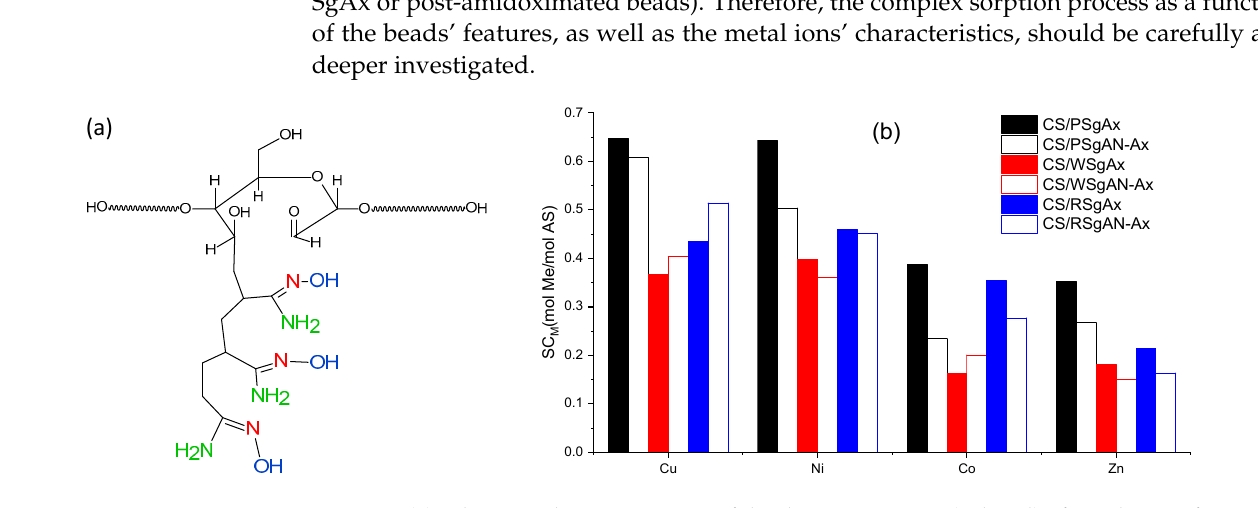
Figure 9. ( a ) Schematical representation of the three active sites (colored) of amidoxime functional group and ( b ) sorption capacity of hydrogel beads CS/SgAN-Ax or CS/SgAx expressed as moles of metal (Me)/moles of active sites (AS) in hydrogel beads.